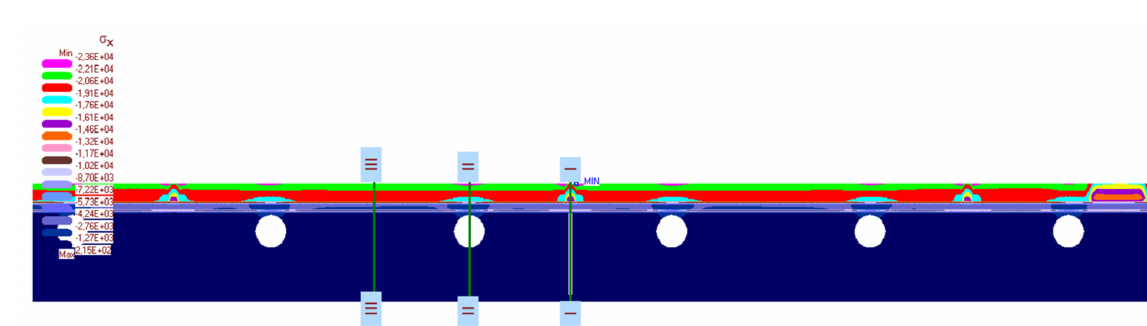
Figure 30. Map of horizontal stresses σ x in the middle zone and cross-sections location.